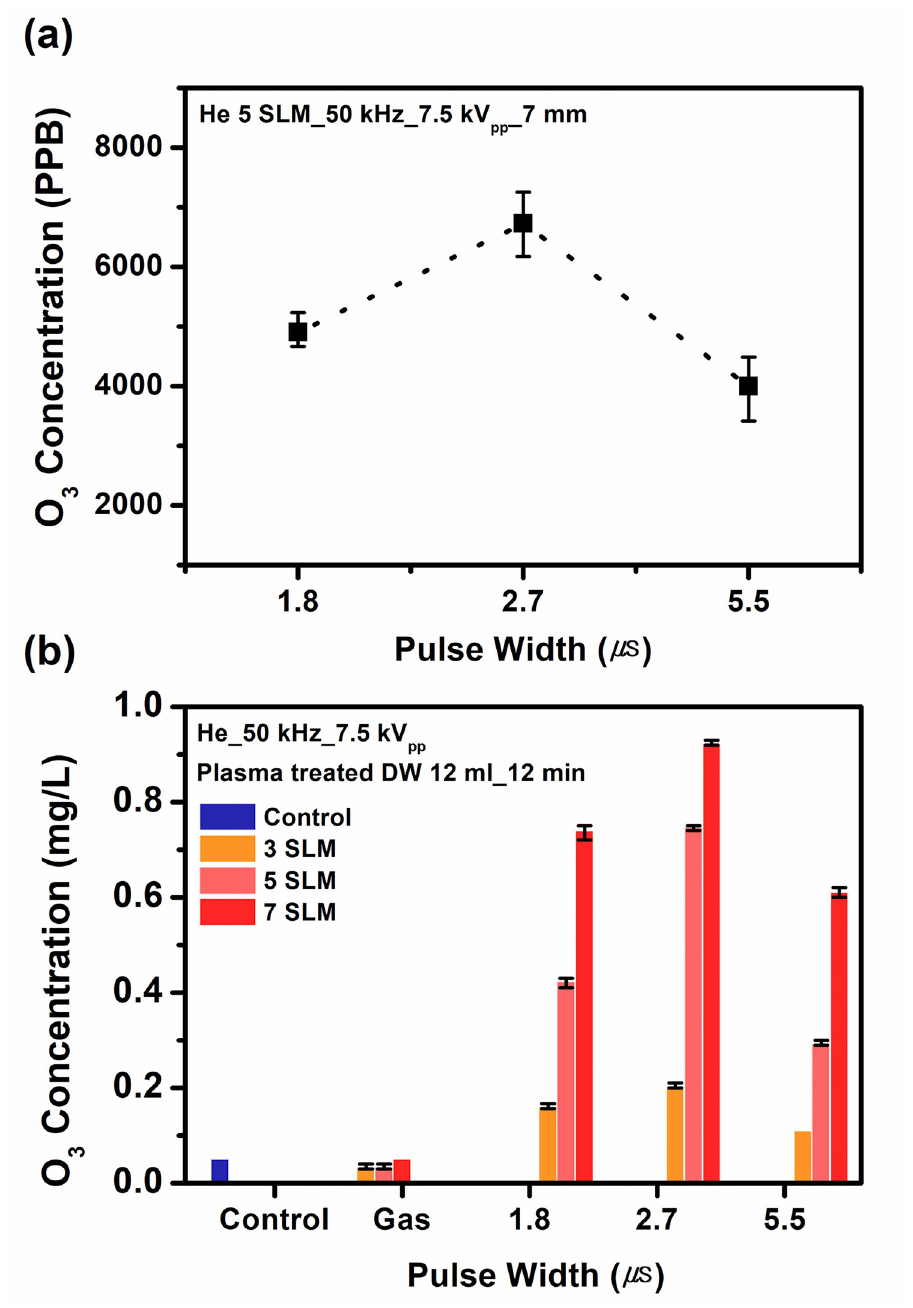
Fig 4. Ozone concentration as a function of pulse width: (a) in the gas phase, (b) in the PAM. Three different gas flow rates (3 SLM, 5 SLM, and 7 SLM) are considered.